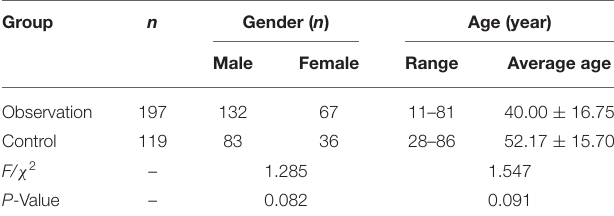
TABLE 1 | Comparison of baseline data between the two groups.